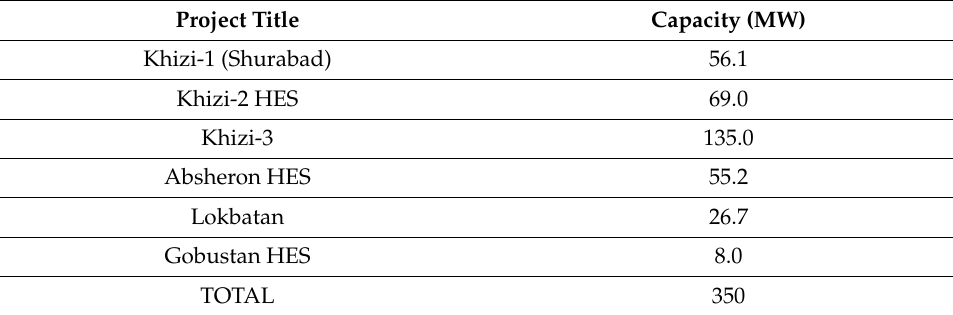
Table 5. List of prospective WEPs offered